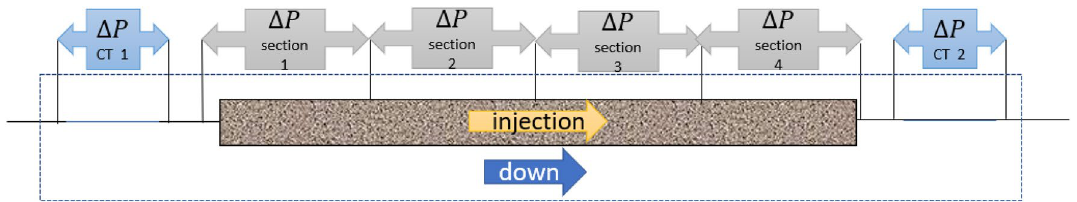
Fig. 2 Sketch of the experimental set-up (flooding rig) with a 76 cm long sand pack in a steel cylinder used in Experiment 7 to 9. The dashed blue rectangle shows what is inside the heating cabinet. The blue lines show the capillary tubes (CT)